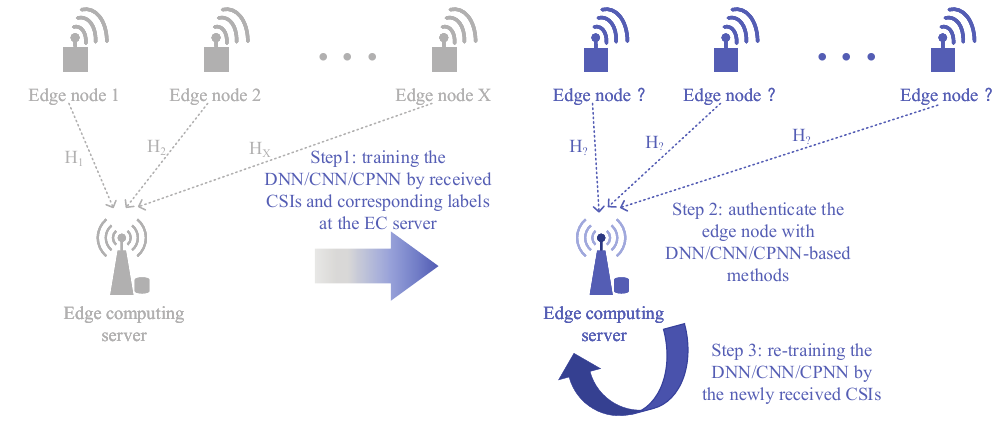
Figure 3. The system model of DL-based PHY-layer authentication in